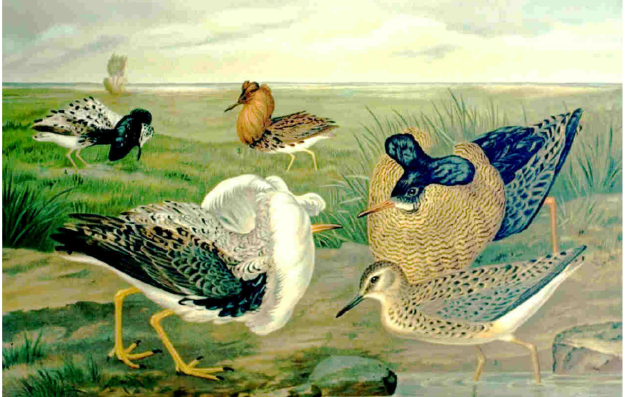
Figure 1. Illustration of ruff plumages: variable darkish males, a whitish male, and a female. The dark male in the background adopts the squat posture (see text). The posture adopted by the whitish male in the forefront is an artistic vision, as a satellite would probably never be seen facing off in